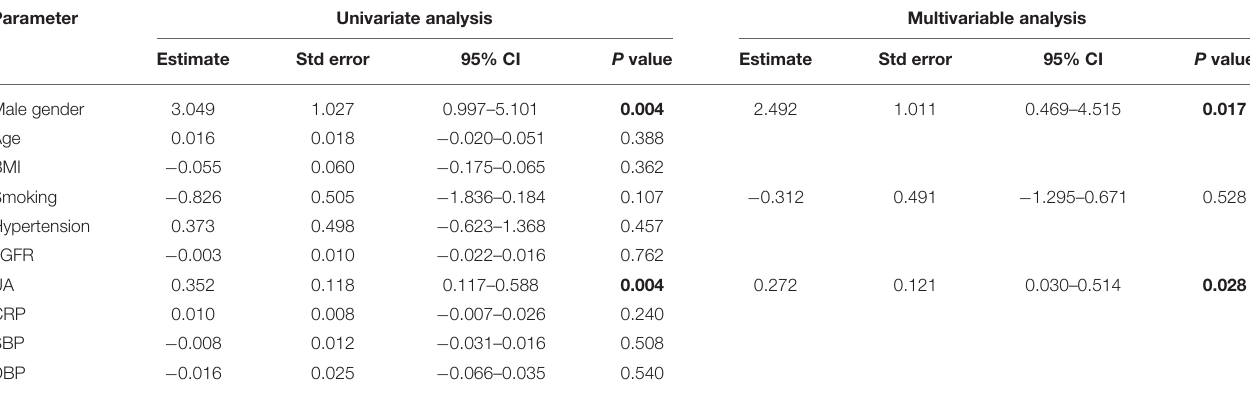
TABLE 3 | Uni- and multivariable linear regression analysis of parameters possibly associated with the number of avascular areas as evidenced with the capillaroscopy.